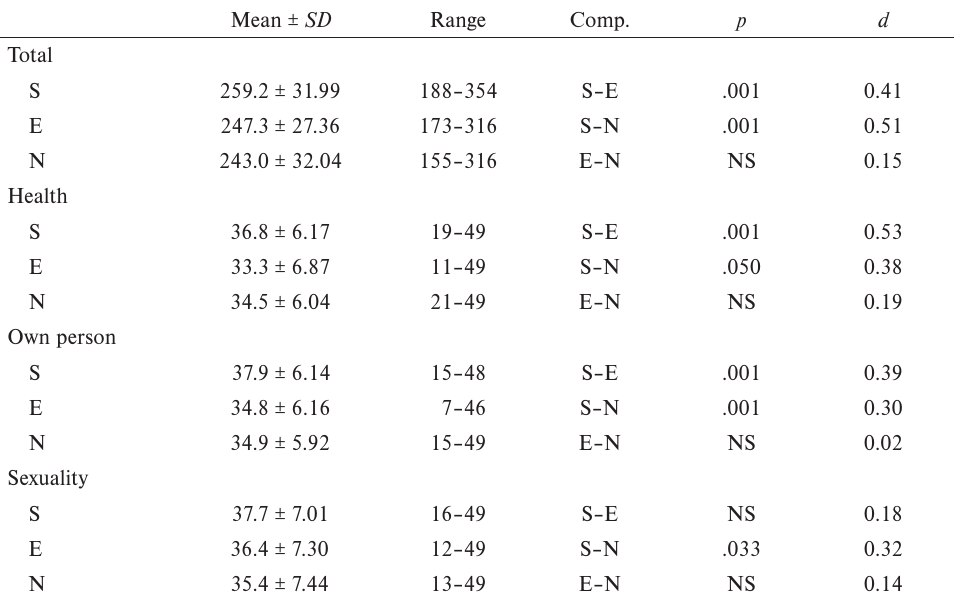
Overall index of life satisfaction, satisfaction with health, own person and sexuality in current university students with respect to study specialization Mean ±